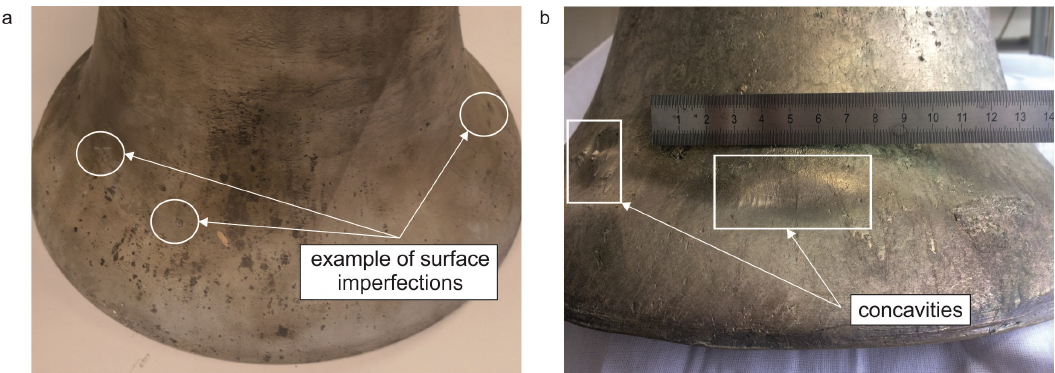
Figure 5. Visual comparison of analyzed bells ( a ) CuSn20; ( b ) CuAl10Fe3Mn2.